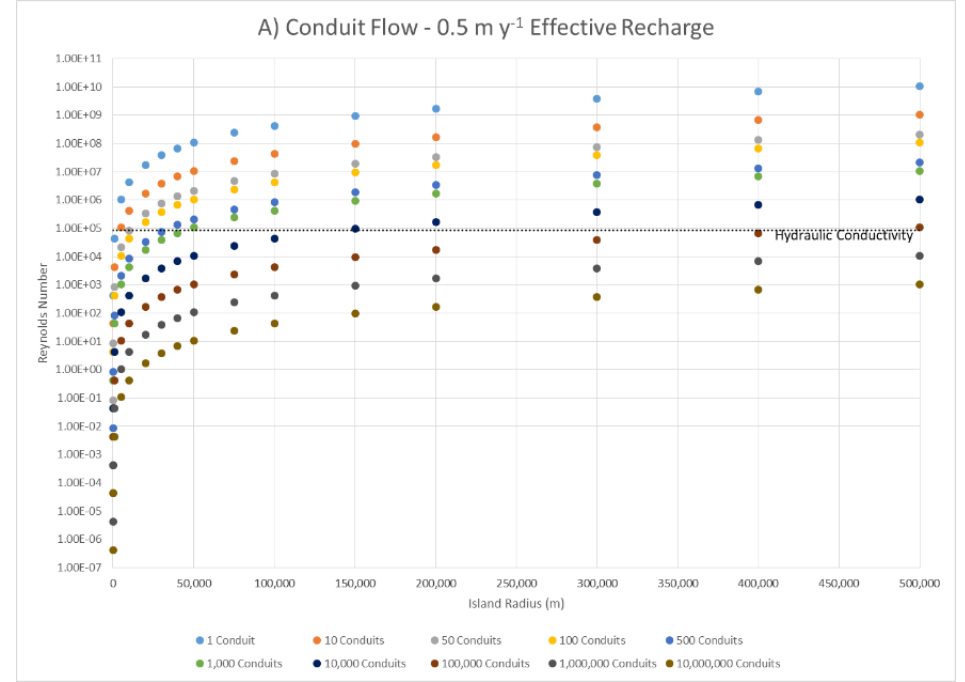
Figure 12. The touching-vug porosity (radius = 0.035 m) trial Reynolds numbers plotted against island size (the scatter plot). Note that for small island sizes, the Reynolds numbers are plotted below the hydraulic conductivity suggested by Whitaker and Smart [28] (the horizontal line), 500 m day −1 , whereas for the larger island sizes, the Reynolds numbers are plotted above the hydraulic conductivity. ( A ) Assuming a recharge rate of 0.5 m y −1 . ( B ) Assuming a recharge rate of 1.0 m y −1 . ( C ) Assuming a recharge rate of 1.5 m y −1 . Note that as recharge increases, the Reynolds numbers increase slightly; however, the effect is minimal.